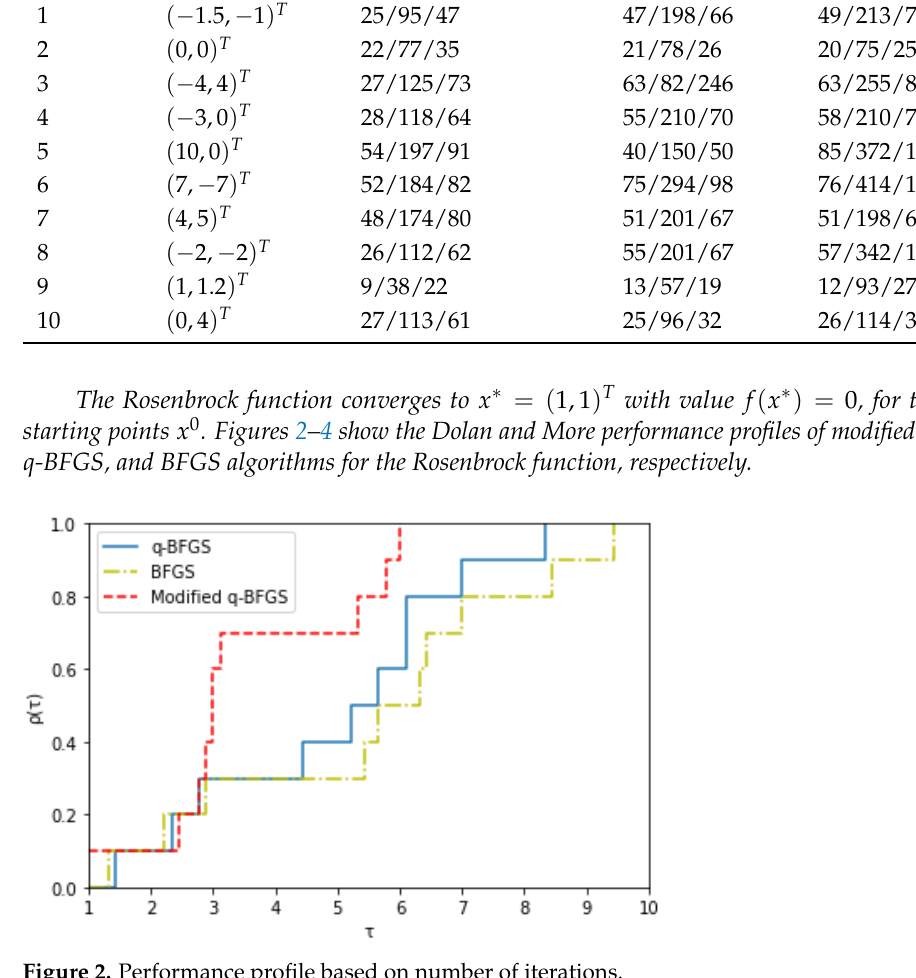
Figure 2. Performance profile based on number of iterations.